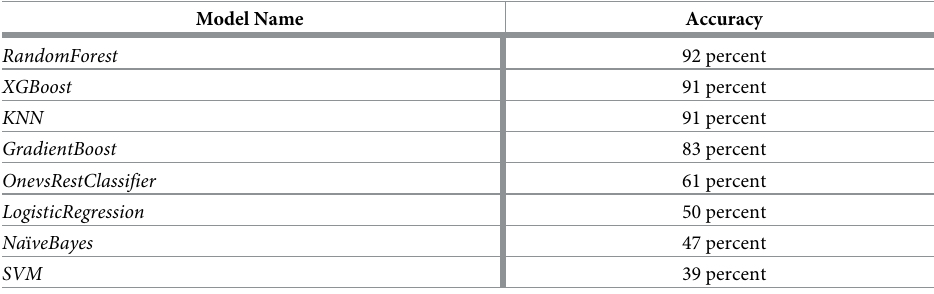
Table 3. Accuracy of different